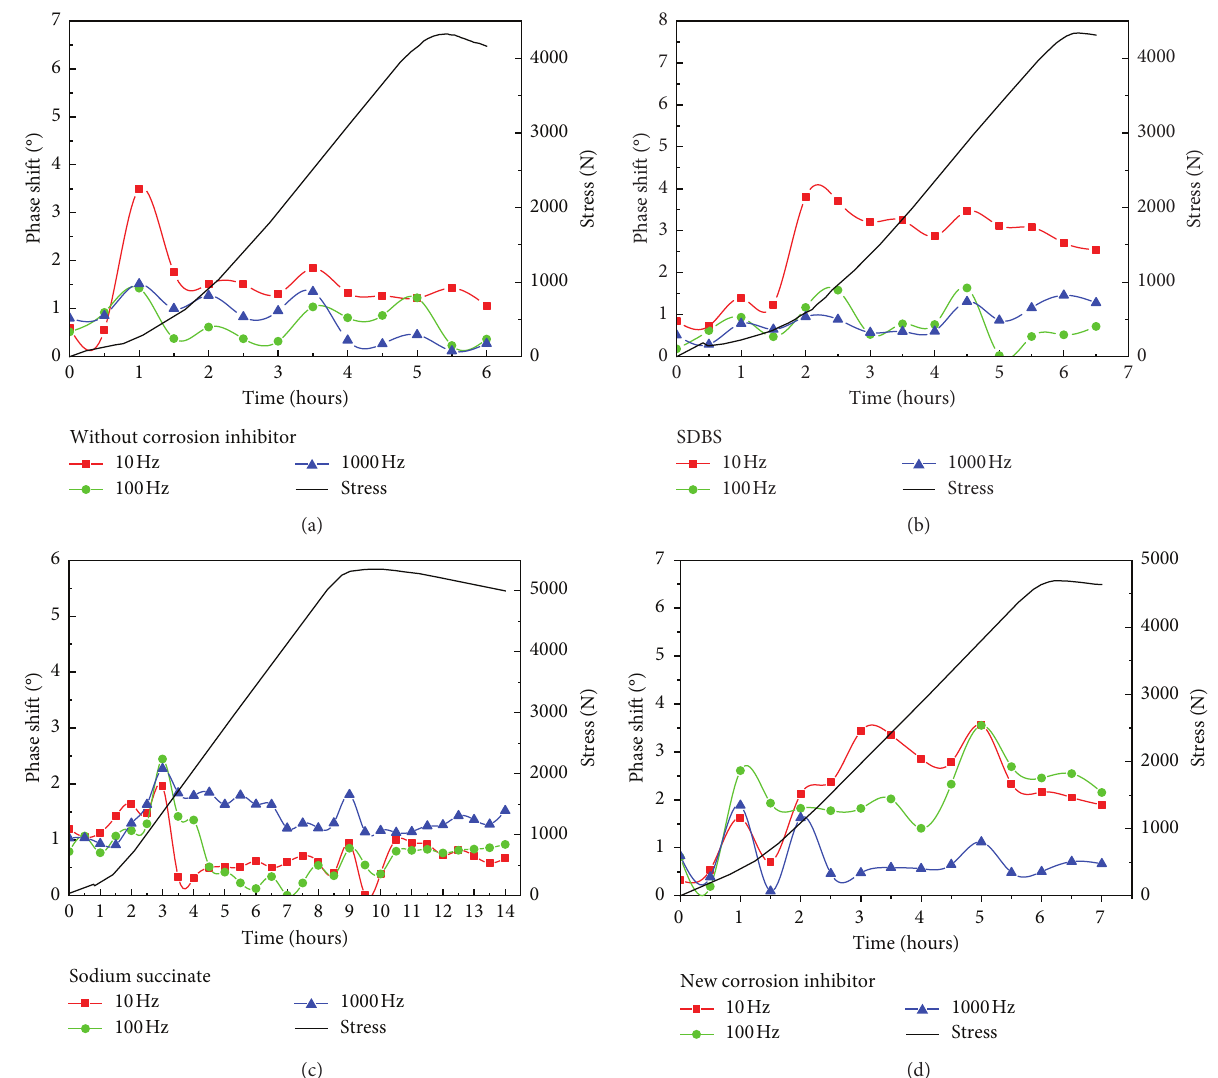
Figure 10: Images of the phase shift-time with different inhibitors: (a) without inhibitor. (b) 0.5 g/L SDBS. (c) 7.5g/L sodium succinate. (d) 0.6g/L new corrosion